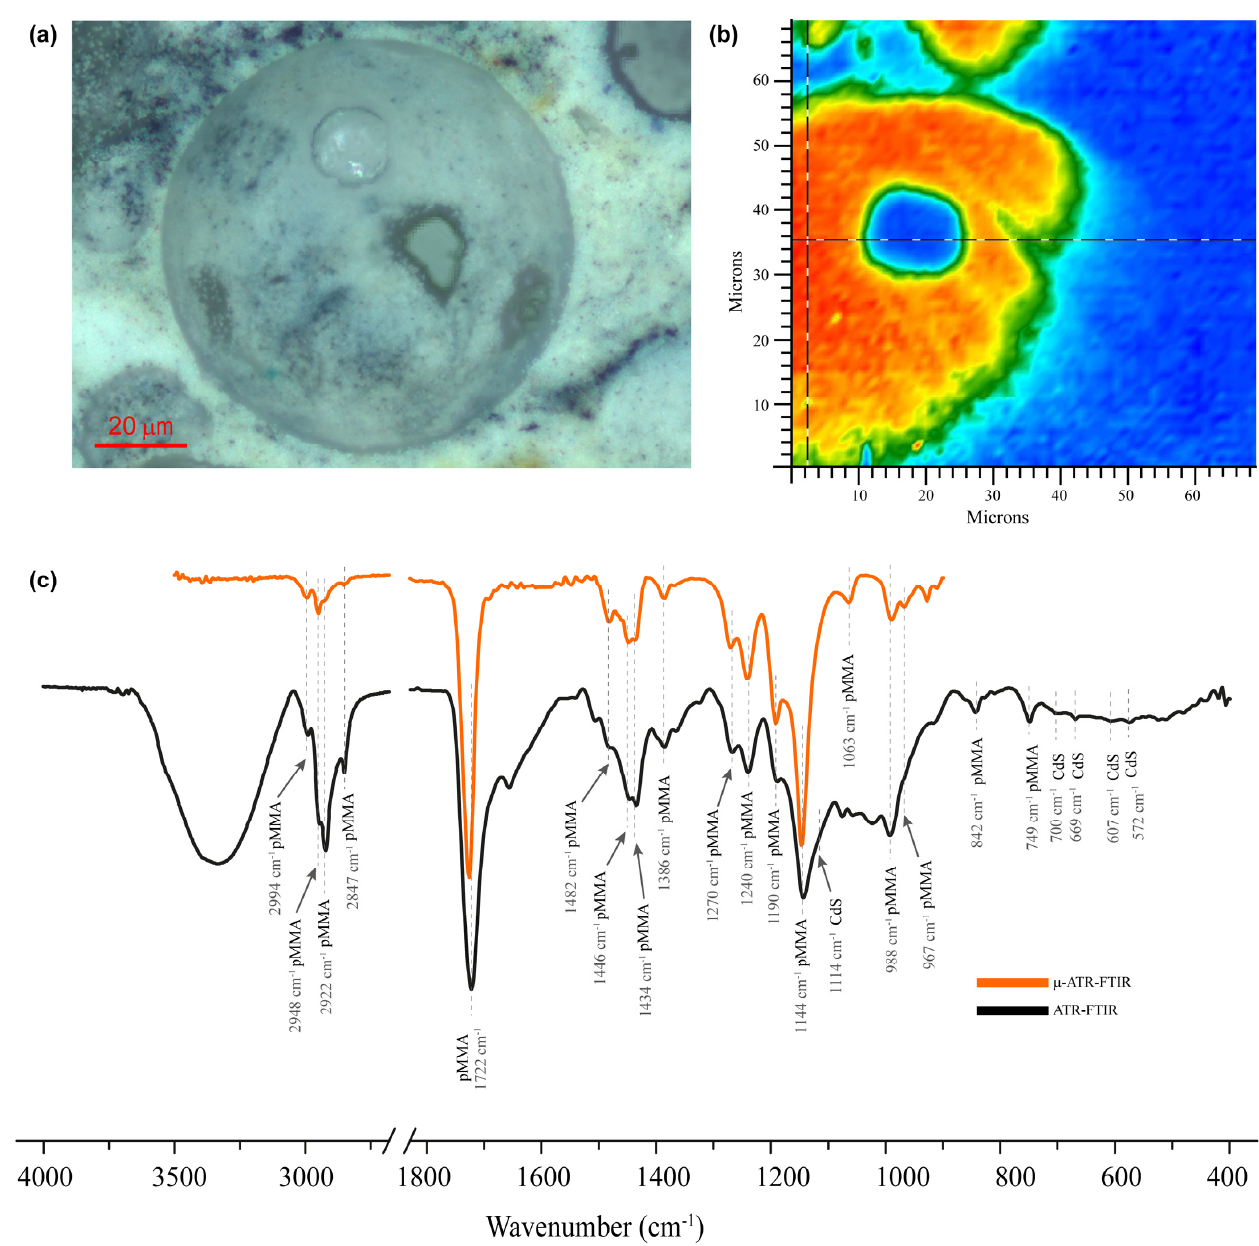
Figure 4. Cross sectional micrograph of the isolated layer yellow sample: ( a ) visible microscopic image, ( b ) chemical map displaying the intensity of the absorbance peaks at 2860 to 3040 cm − 1 , ( c ) comparison between ATR-FTIR (dark line) and micro-ATR-FTIR spectra obtained from the high- lighted region in false color image (orange line).